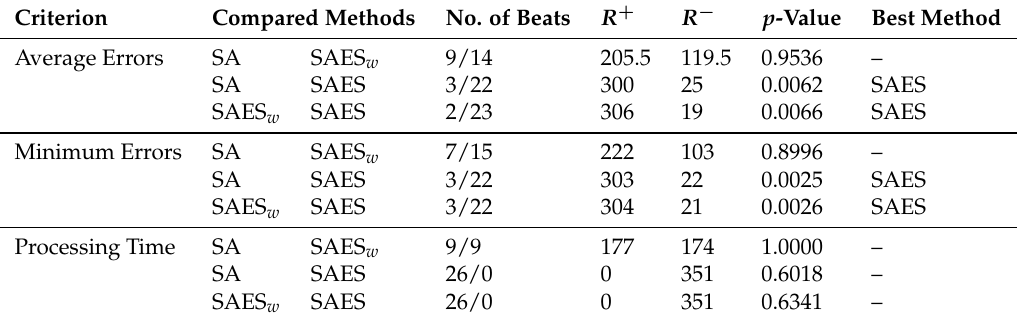
Figure 4. Averages of processing time in seconds using the hard test functions. Table 5. Wilcoxon rank-sum test for the results of SA methods using the classical test functions. Criterion